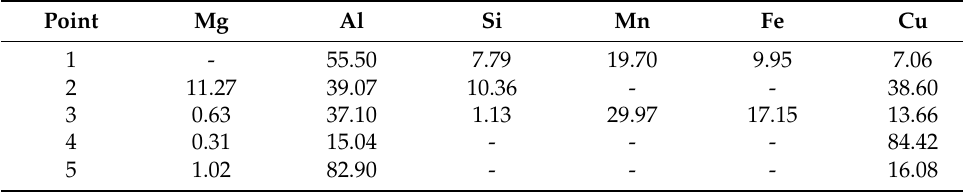
Table 2. EDS analysis results of areas 1–5 in Figure 5f